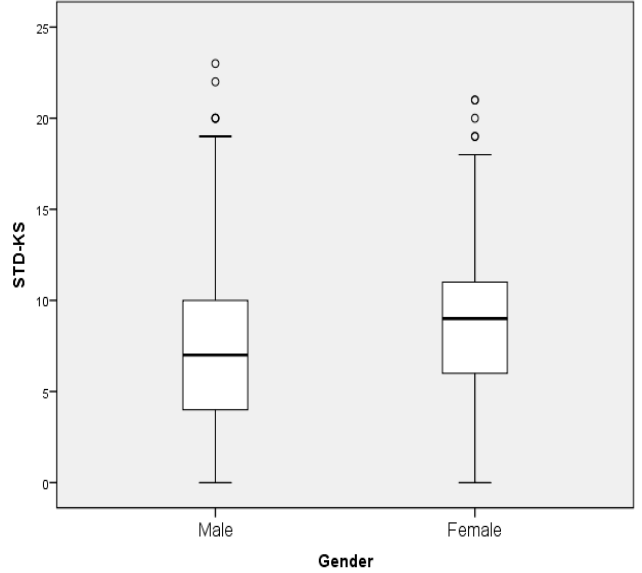
Figure 2. Box-plot of sexually transmitted disease knowledge scores by gender.